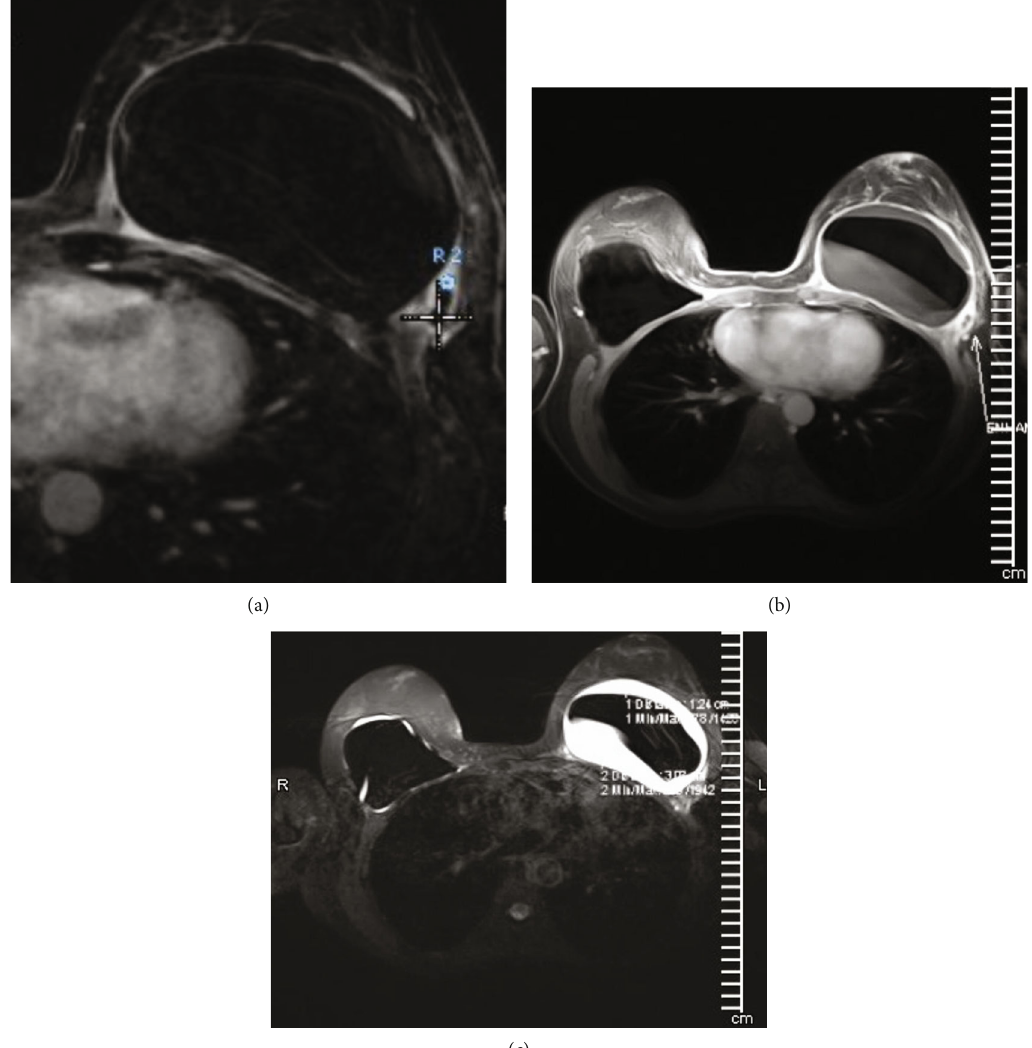
Figure 1: (a – c) MRI images of periprosthetic fl uid and mass.